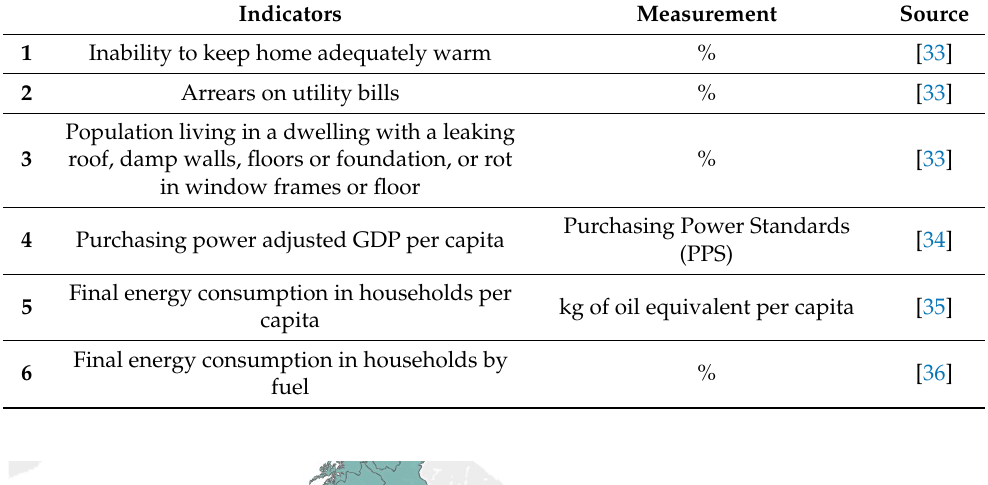
Table 1. Indicators retrieved from Eurostat and used for the analysis.